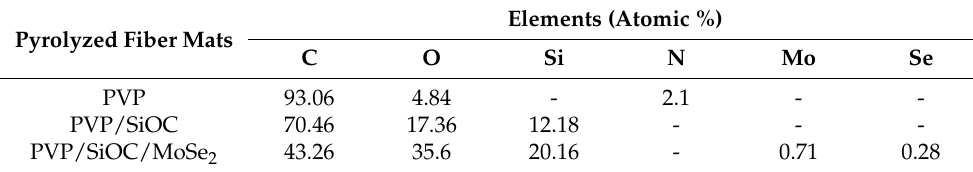
Figure 5. XPS survey scan of pyrolyzed PVP, PVP/SiOC, and PVP/SiOC/MoSe 2 fiber mats. Table 1. Elemental composition of the fiber mats by XPS.